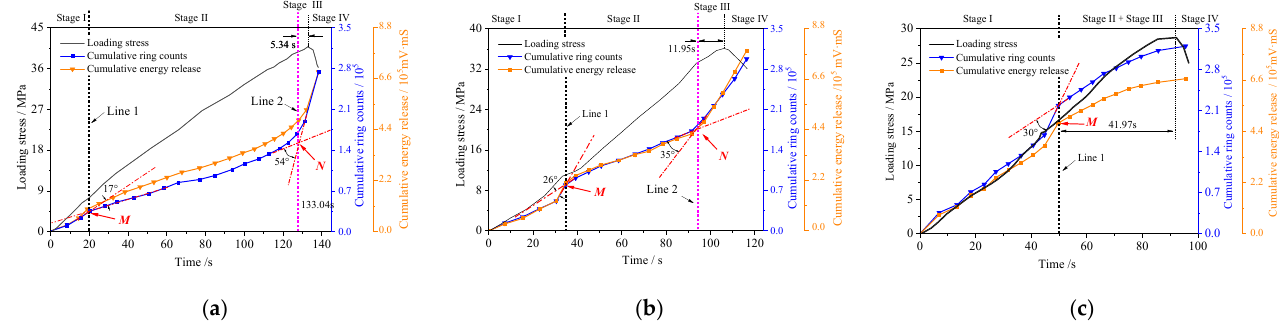
Figure 13. AE signal–time and stress–time curves of concrete with different graphite powder content during compressive tests. ( a ) C1; ( b ) C2; ( c ) C3.